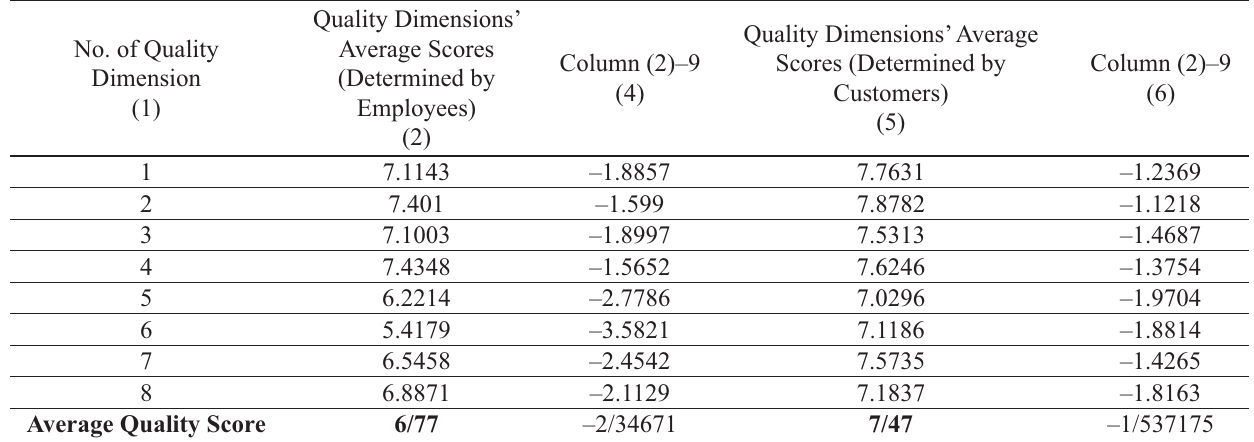
Table 2. Data for SERVQUAL Model